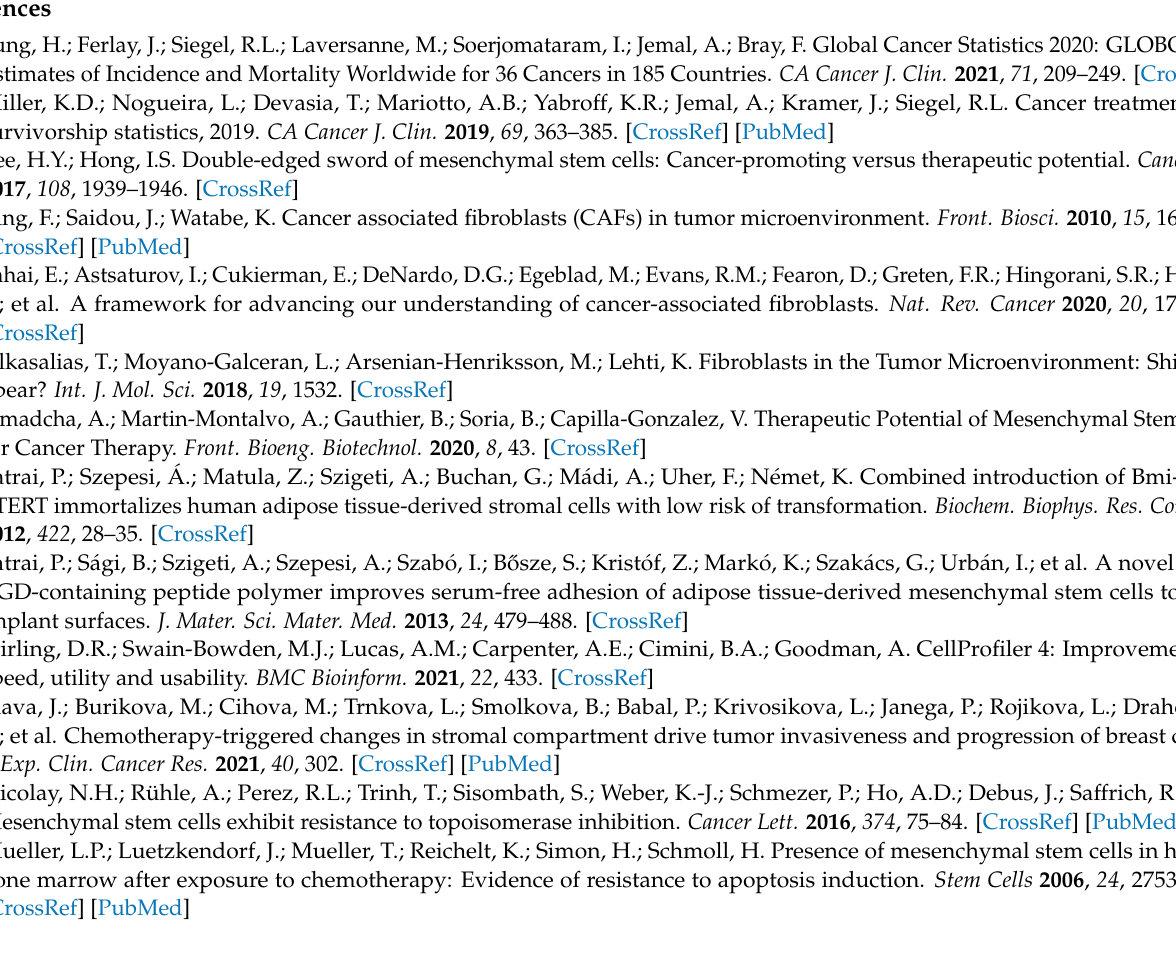
of 9 drugs measured across 9 cell lines. Supplementary Figure S3: Effects of 10 µ M cisplatin on double-strand break and apoptosis induction in Ad-MSC 3 and A431